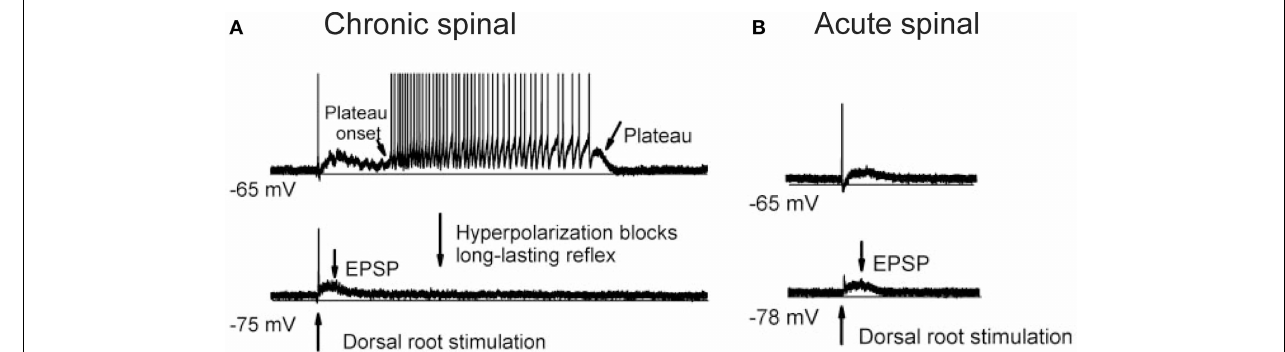
FIGURE 1 | Re-emergence of PICs after chronic SCI. (A) Re-emergence of PICs in a completely transected (S2) rat after chronic ( > 50 days post-injury) SCI. Motoneuron recording in response to single pulse (3 × ’s sensory threshold) dorsal root stimulation. At resting membrane potential ( − 65mV, top trace), PIC activation produces a plateau potential and self-sustained firing. Hyperpolarization of the motoneuron ( − 75mV, bottom trace) deactivates the PIC, eliminating the long-lasting reflex (LLR or spasm)